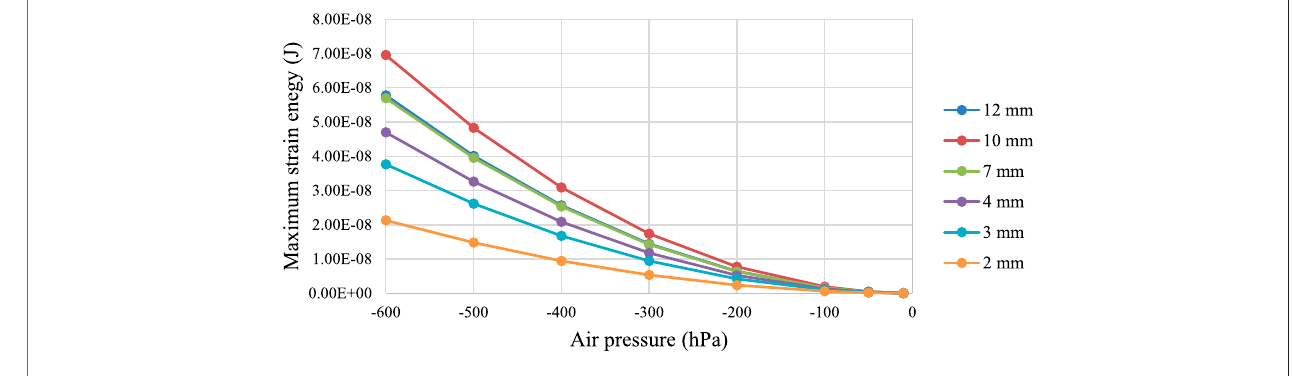
FIGURE 12 | Maximum strain energy per air pressure by each suction diameter.